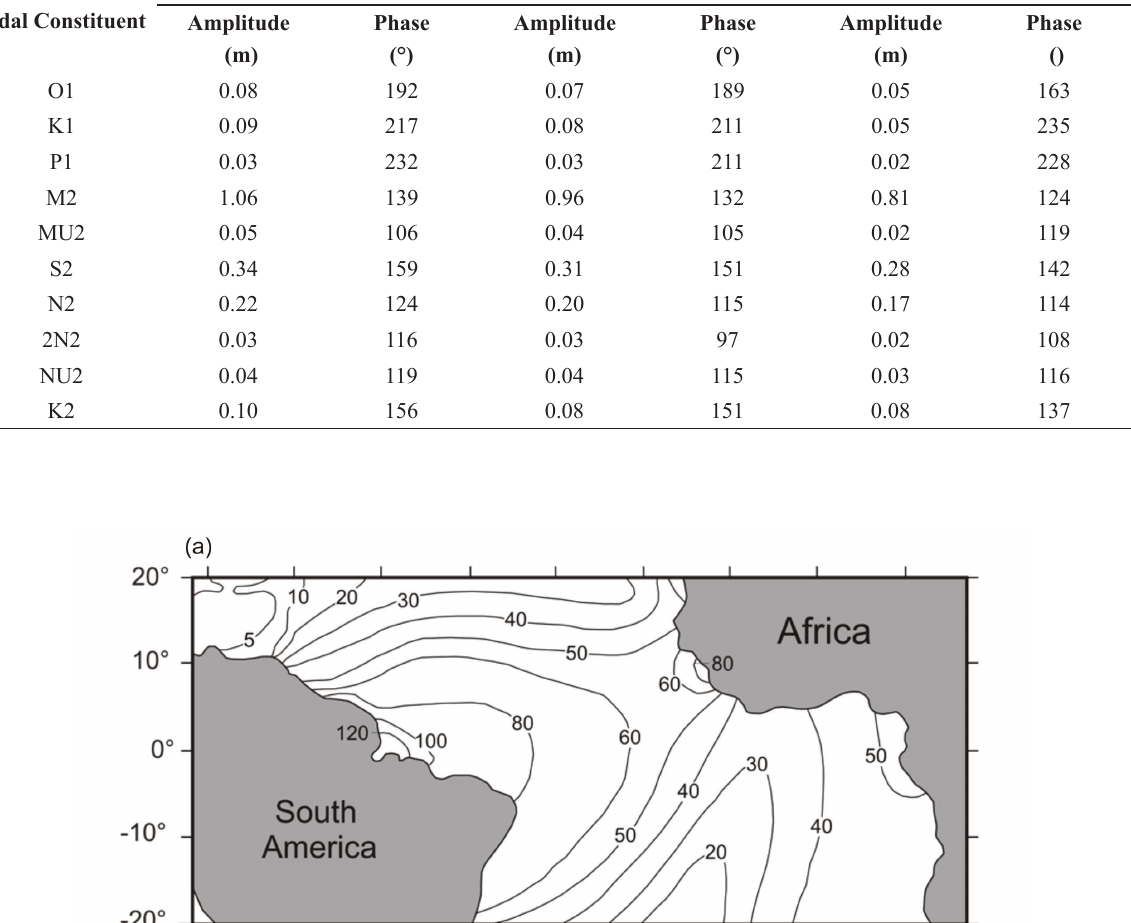
Main tidal harmonic constituents (amplitudes and phases) for luis Correia (pi), Fortaleza (Ce), and Natal (RN). luis Correia - pi Fortaleza - Ce Tidal Constituent